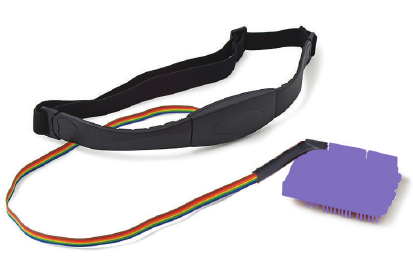
Figure 7: Position sensor (adapted from [12]).